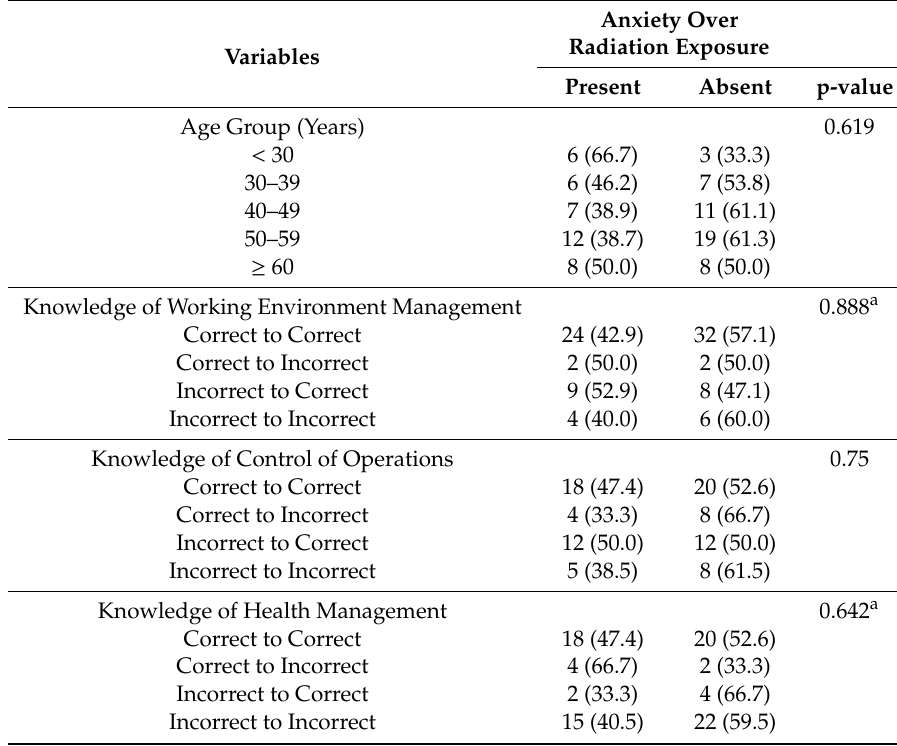
Table 2. Associations of anxiety over radiation exposure before training session with age and answer patterns. Variables